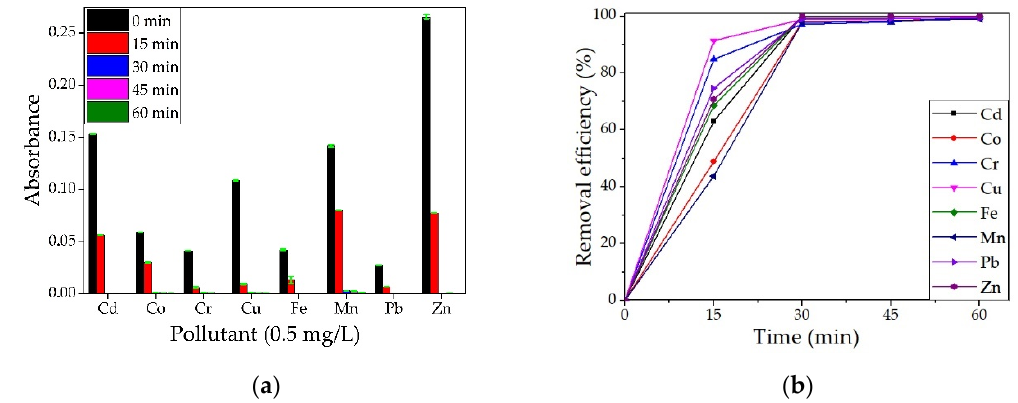
Figure 16. Qualitative analysis on a multielement solution (concentration 0.5 mg/L) for BPA ( a ) and removal efficiency ( b ).